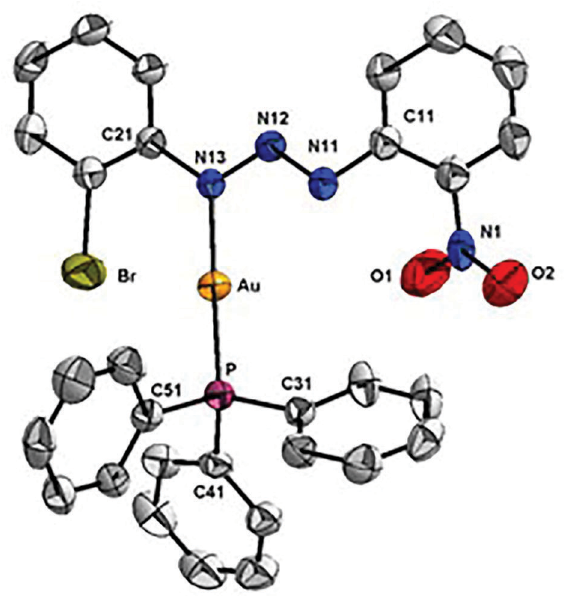
FIGURE 2 - Triazenide gold complex structural projection (I). Thermal ellipsoids with probability level of 50%. Hydrogen atoms omitted for better